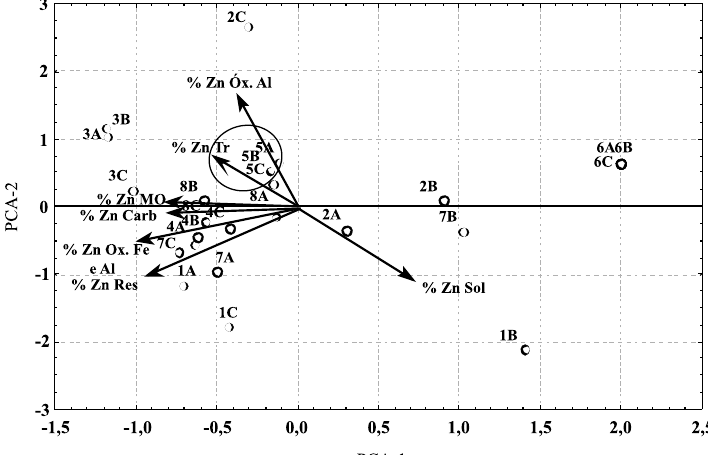
Figura 3. Gráfico dos componentes principais (PCA-1 e PCA-2) das amostras e da distribuição percentual do Zn total em cada fração da análise sequencial: Sol.: solúvel; Troc.: trocável; Carb: carbonatos; MO: matéria orgânica; Óx. Fe e Al: óxidos de F e Al amorfos; Óx. Al: óxidos de Al cristalinos e minerais secundários filossilicatados (1:1 e 2:1); Res: residual. NOTA: O número representa o ponto de coleta, e a letra, a profundidade. (A= 0 a 10 cm; B= 10 a 20 cm; C= 20 a 40